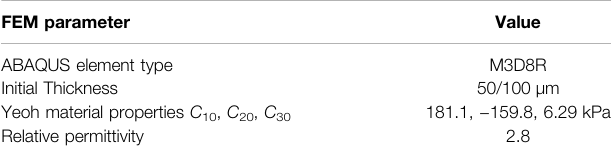
TABLE 1 | Parameters used for FEM simulation of DEAs. Yeoh parameters were taken from (Kuhring et al., 2015), dielectric permittivity taken from manufacturer speci fi cations (Wacker Chemie AG, 2020).